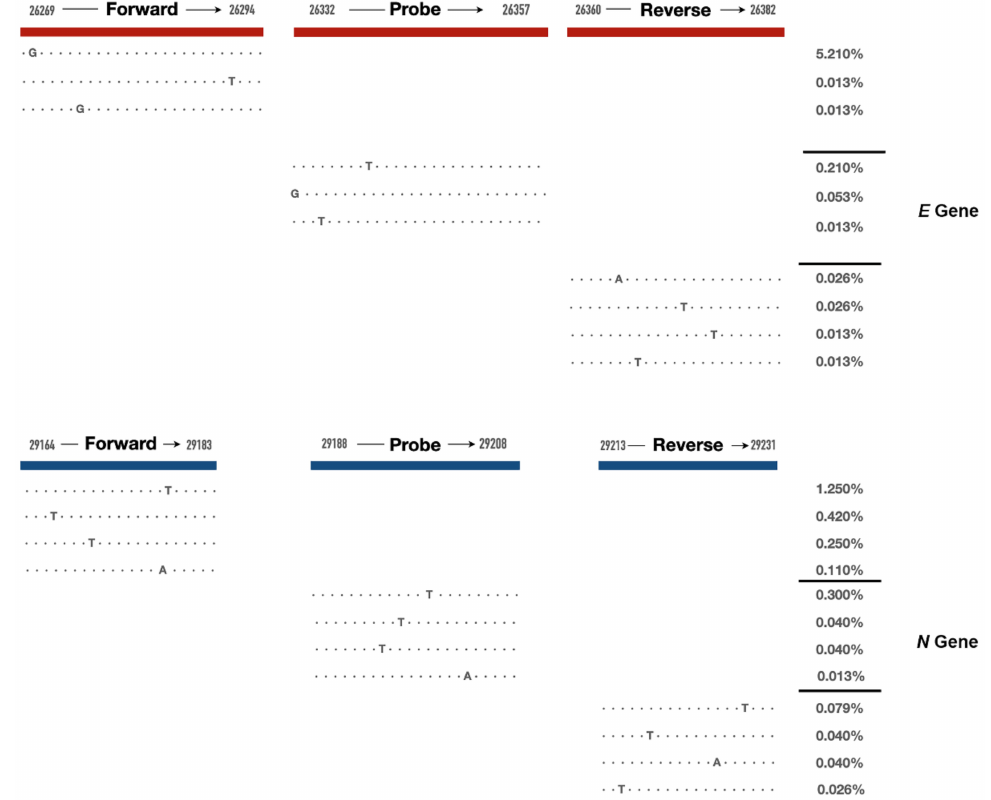
Figure 2. Mutations in the primers and probes identified in the local New York City communities. Wild-type sequences are shown as dots, and sites with mutations at the highest frequency are indicated by the mutated nucleotide. The percentages of genomes with mutations out of all genomes are listed on the